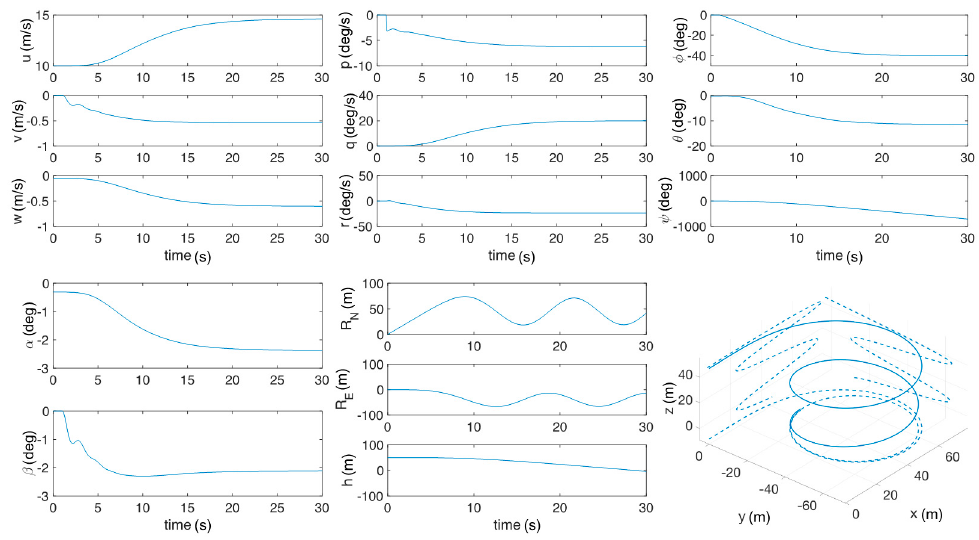
Figure 9. UAV response to unit step ailerons.